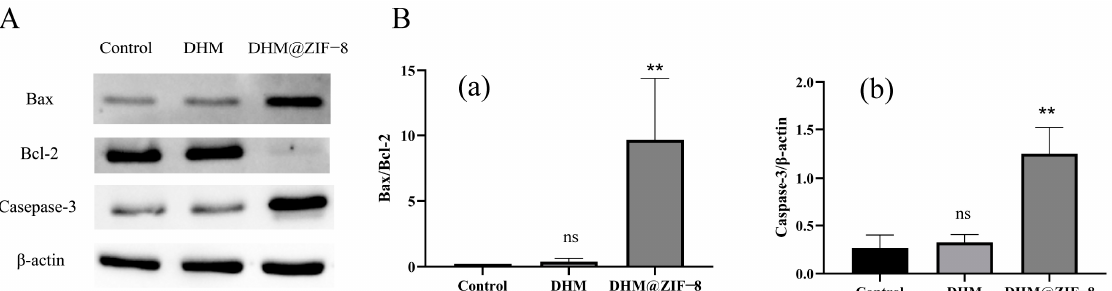
Figure 9. ( A ) Detection of apoptosis-associated proteins in cells treated with DHM or DHM@ZIF-8. ( B ) Quantitative analysis of protein expression. ( a ) The Bax/Bcl-2 ratio and ( b ) The expression of Caspase-3. Data are representative of three independent experiments. ns represents no statistical significance, ** p < 0.01 vs. control .